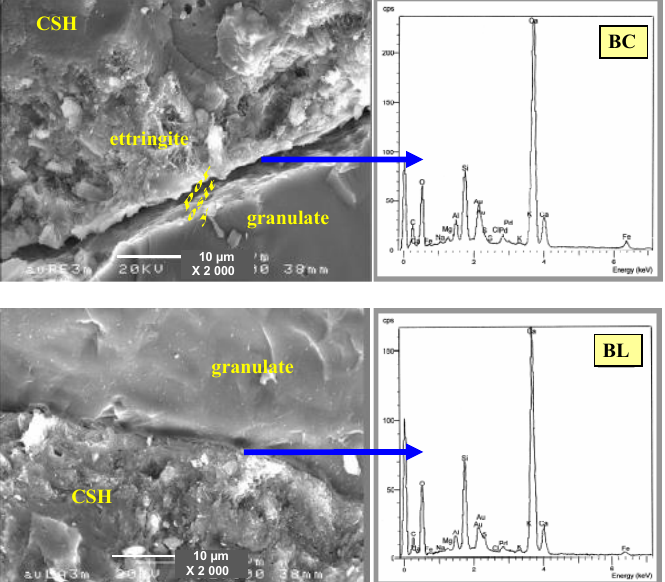
Fig. 10. SEM observation of transition halo of different concretes after 365 days of